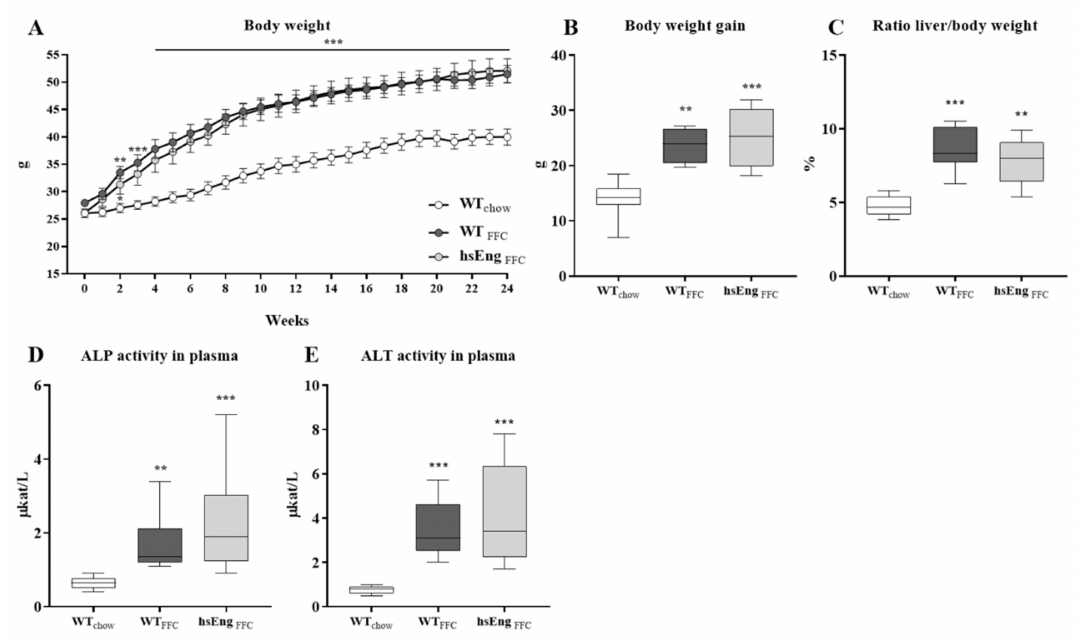
Figure 1. FFC diet and hsEng e ff ects on body and liver weight as well as Alkaline phosphatase (ALP) and Alanine transaminase (ALT) activity. Increases in the bodyweight of each mouse were monitored at 1-week intervals throughout the 24 weeks of chow or FFC diet feeding ( A ). Bodyweight gain ( B ) and ratio liver / body weight ( C ) of mice after the feeding period. The activity of ALP ( D ) and ALT ( E ) in plasma. The data are presented as median with box and whiskers representing the interquartile range and 5th–95th percentiles ( n = 8). * p < 0.05 ** p < 0.01, *** p < 0.001, using the Kruskal–Wallis